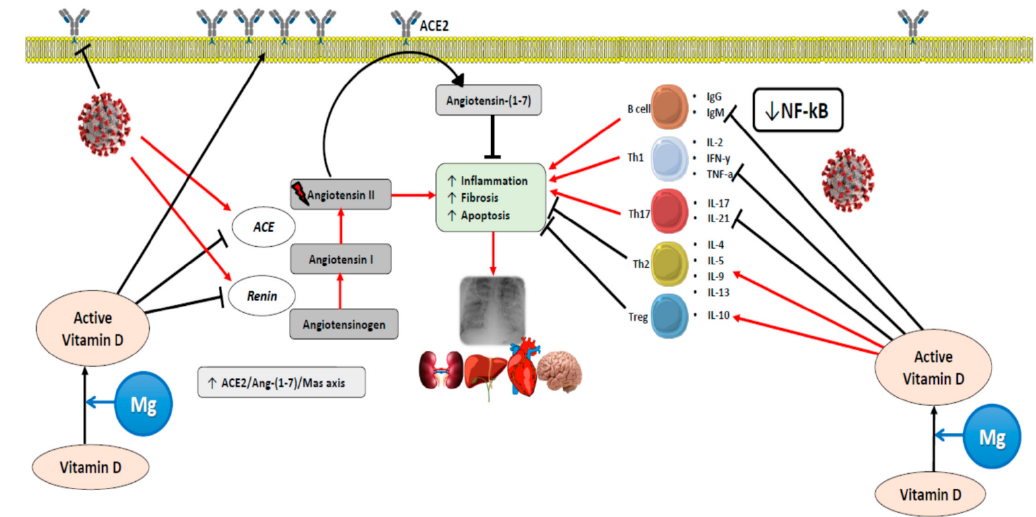
Figure 4. Proposed mechanisms by which vitamin D and Mg can exert actions against COVID-19. ACE, angiotensin- converting enzyme; ACE2: angiotensin-converting enzyme 2; Ang-(1-7), angiotensin (1-7); Ig, immunoglobulin; IFN- γ , interferon gamma; IL, interleukin; NF- κ B, nuclear factor kappa-light-chain-enhancer of activated B cells; TNF-a, tumor necrosis factor alpha; Th, T helper cell; Treg, regulatory T